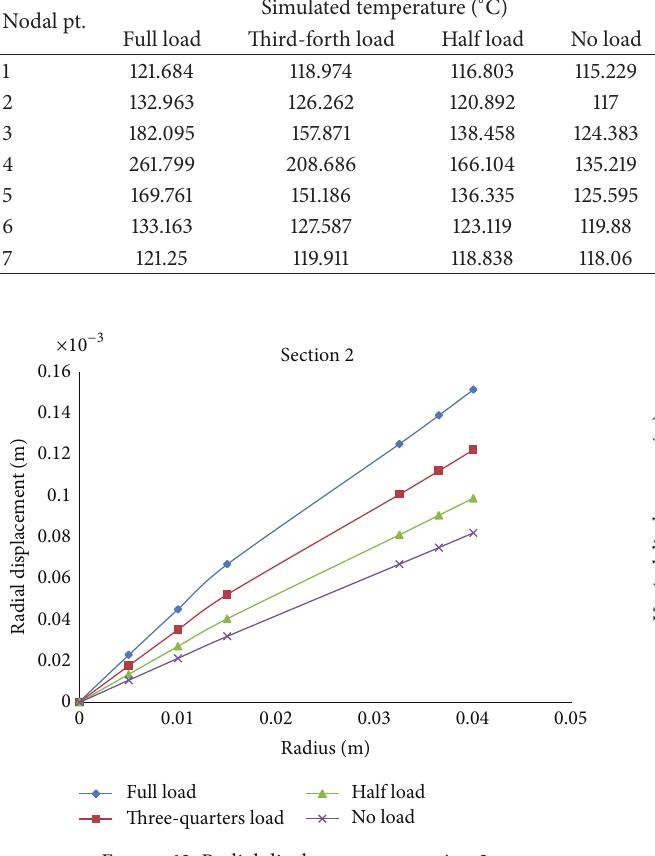
Figure 12: Radial displacement at section 2.